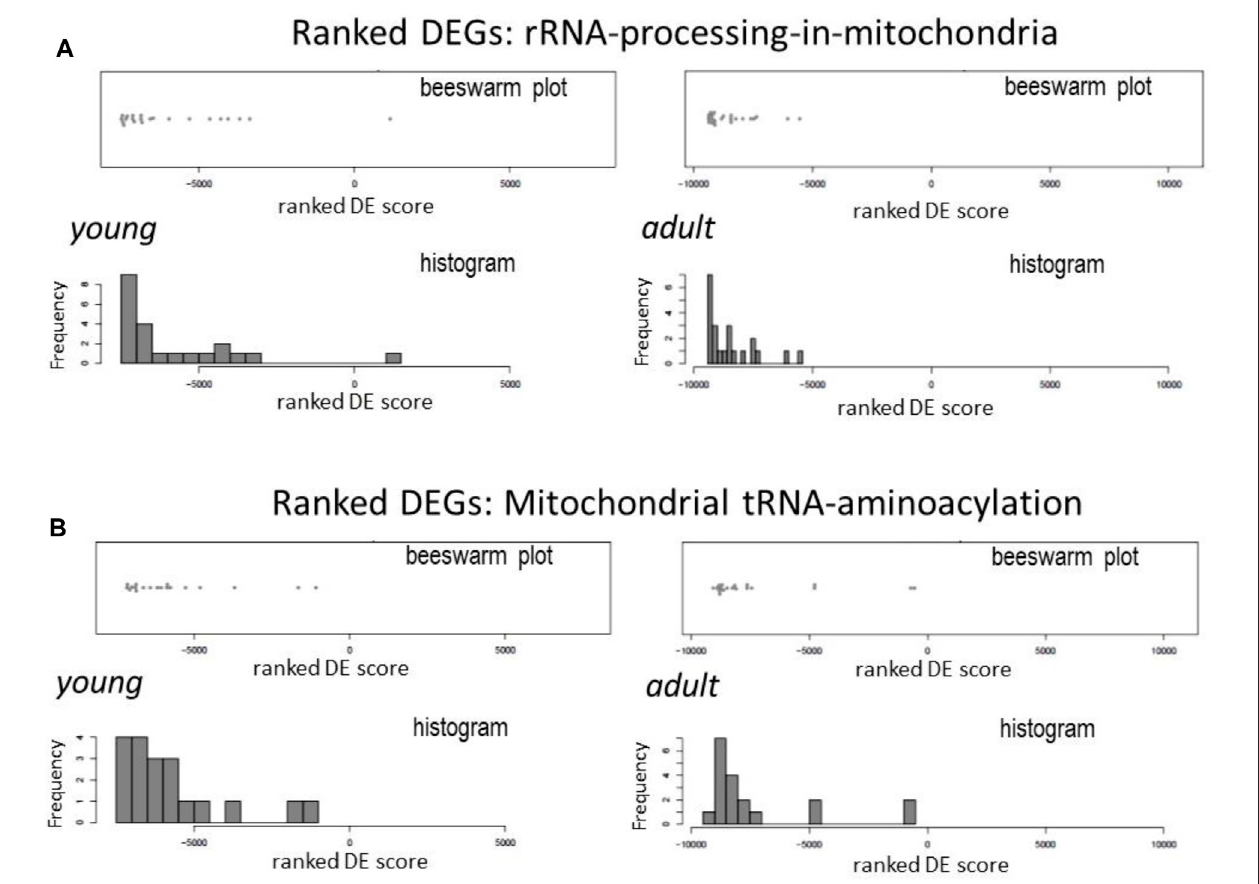
FIGURE 3 | Downregulation in DCM hearts of genes coding for mt-rRNA processing and aminoacyl-tRNA synthesis enzymes. Beeswarm plots and histogram of relative changes in the expression of genes for mitochondrial RNA processing (A) and aminoacyl-tRNA synthases (B) .